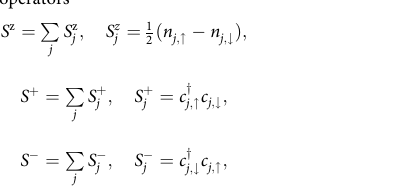
(cid:4) (cid:8)(cid:4) (cid:8) ð t Þ for the open and the closed 3 exp ð(cid:2) β H Þ with β ¼ 0 : 2 = τ ; U ¼ τ and B = 0.2 τ of N = 4